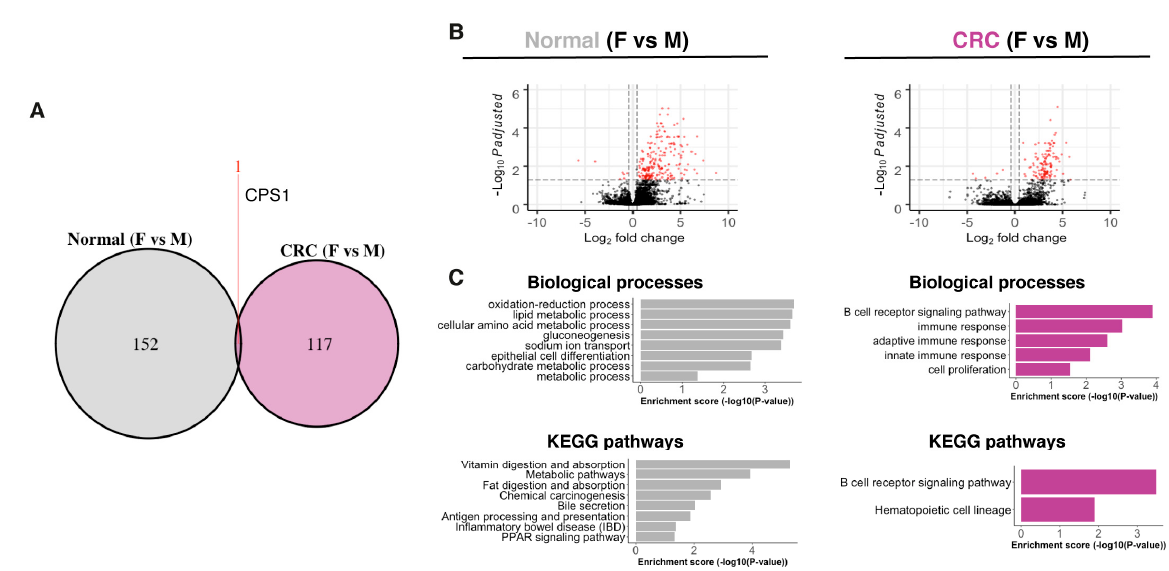
Figure 1. Sex differences in a normal colon and colorectal cancer (CRC) transcriptome. ( A ) Venn diagram comparing sex differences in the transcriptome of a normal colon and CRC. ( B ) Volcano plot showing differentially expressed genes (DEG) between sexes in a normal colon and CRC. ( C ) Biological process and KEGG pathway enrichment analysis of the DEG between the sexes in a normal colon and CRC.